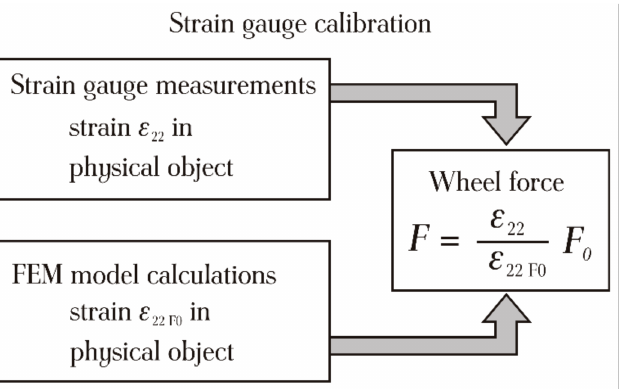
Figure 8. Calibration of sensors by means of FEM helps to determine the forces in a wheel.